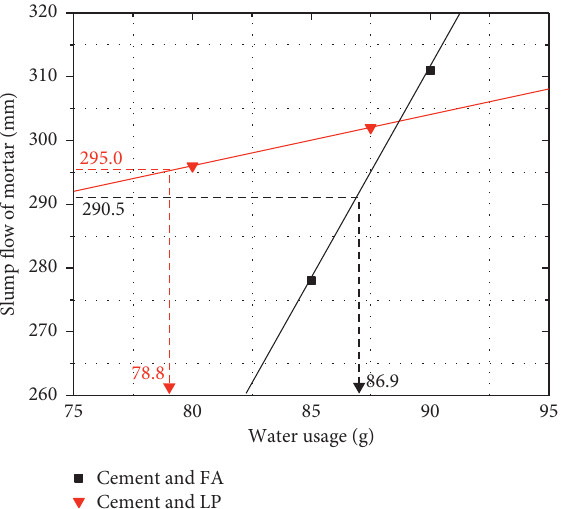
Figure 5: Relationship between slump flow of mortar and water